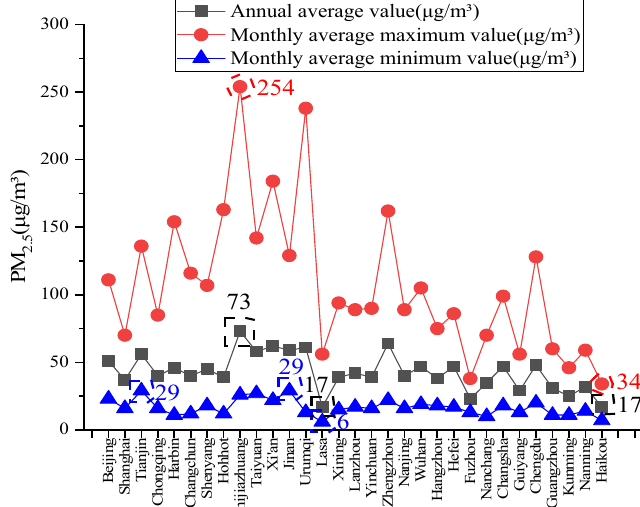
Figure 1. Average concentration of PM 2.5 in major cities of China from 2016 to 2020. 3.2. The Change in PM 2.5 Concentration Using the Method of No-Guarantee Days The monitoring data for 31 provincial capitals in China, from 2016 to 2020, were counted and analyzed based on the existing relevant research and conclusions. The outdoor atmospheric PM 2.5 concentration values, corresponding to the different not-guaranteed day parameters, are given in Table 1 [6,15]. Table 1. The outdoor calculated concentrations of PM 2.5 in 31 cities.